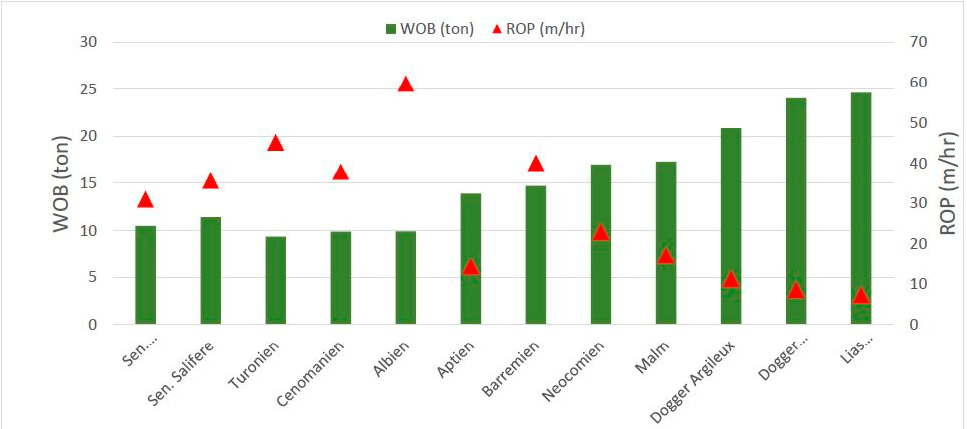
Figure 14. Data collected from BlackBox TM of WOB and ROP in Well-1.